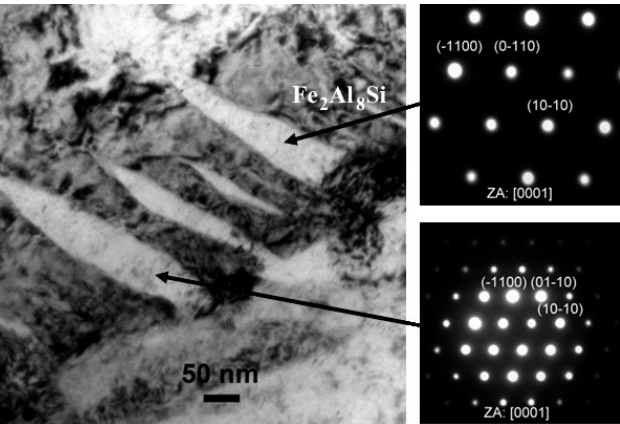
Figure 11. TEM micrograph of the interface between the Fe 2 Al 5 layer and the outermost coating layer. Lenticular-shaped zones were identified by SAEDPs (insets) as Fe 2 Al 8 Si.